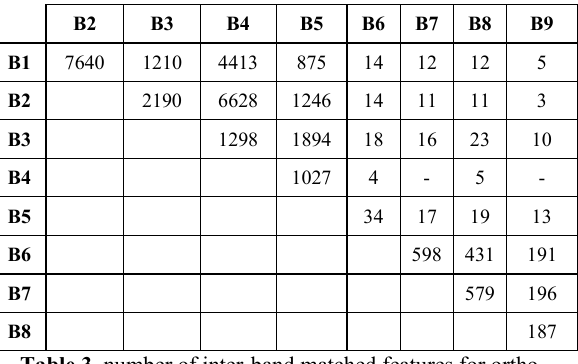
Table 3 . number of inter-band matched features for ortho- images generated using the pre-calibration